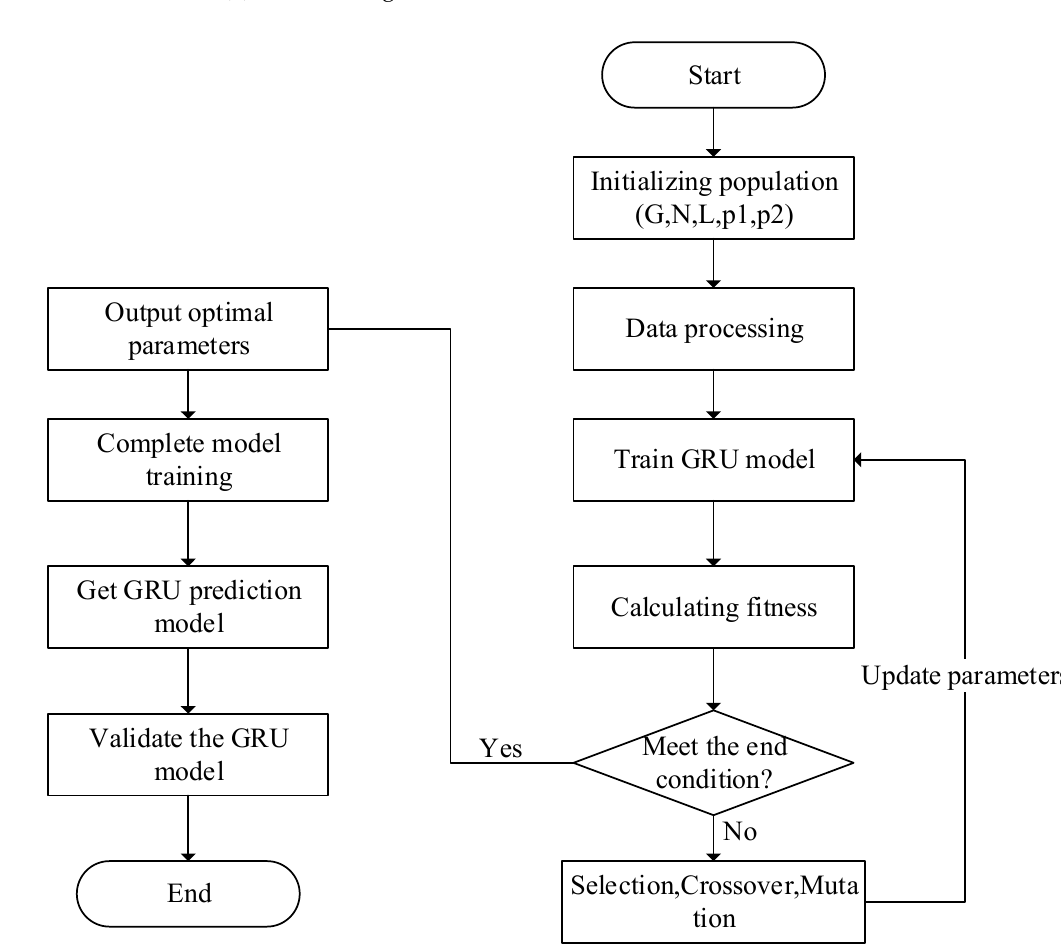
Figure 3. The implementation process of GA-GRU model.